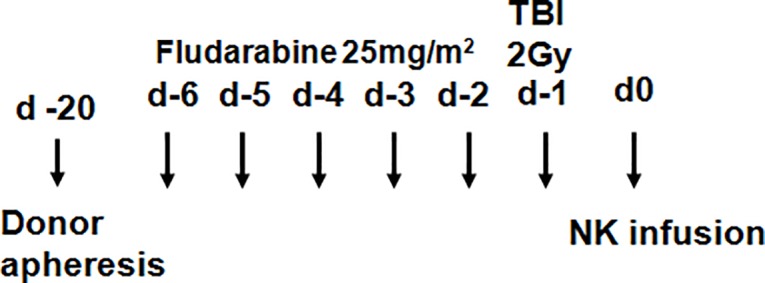
Patient conditioning regimen.